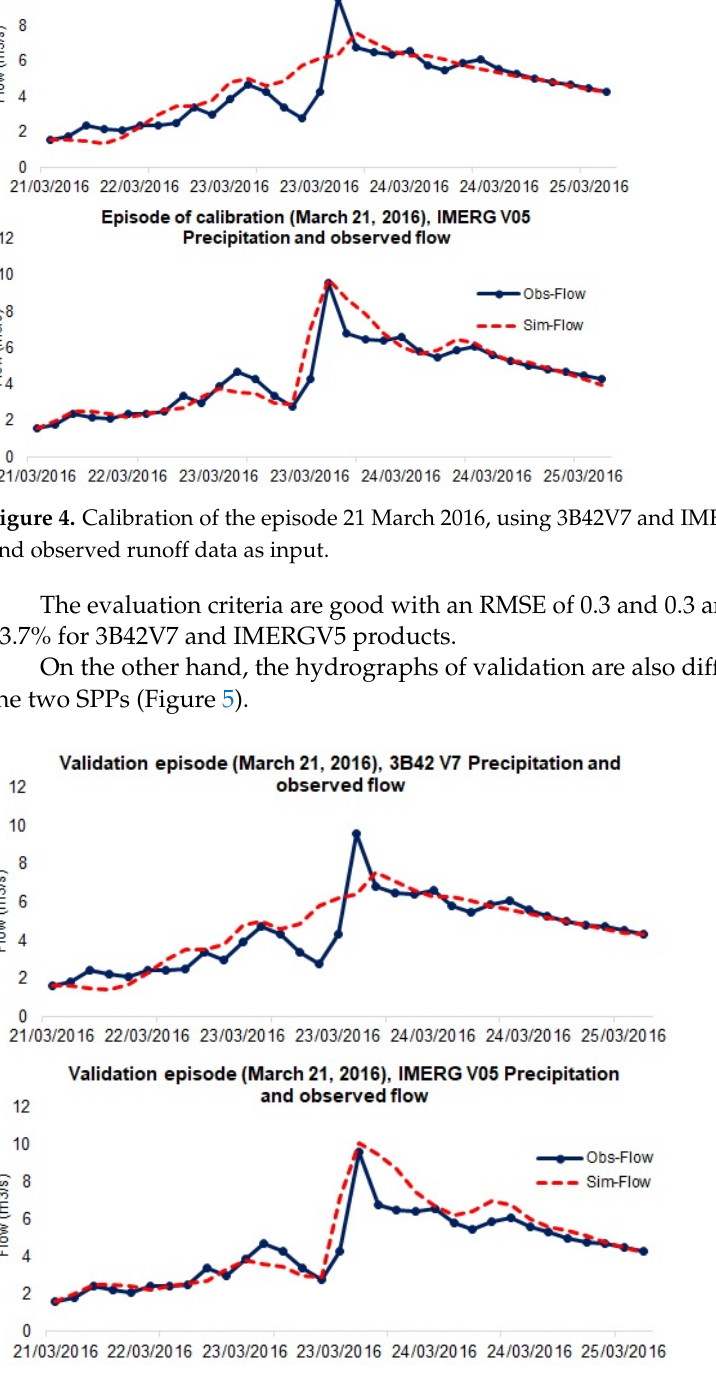
Figure 5. Validation of the episode of 21 March 2016, of 3B42V7 and IMERG V05 rainfall products and observed runoff data as input using the means calibration parameters of the gauge precipitation calibration.